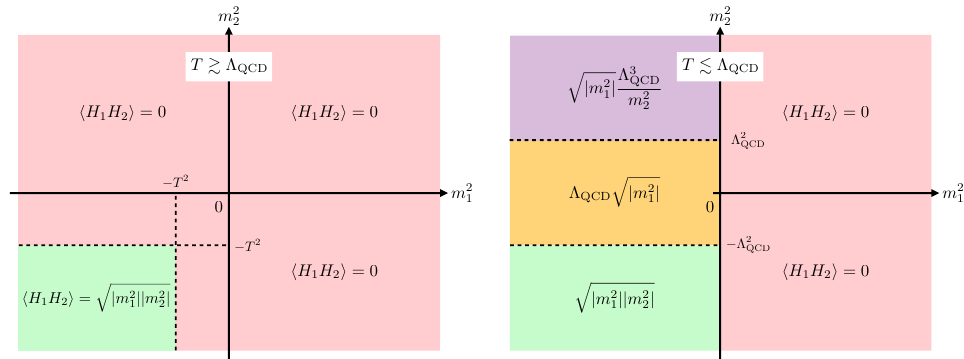
Figure 10 . Vacuum expectation value of H 1 H 2 in the model of eqs. (5.3) and (5.5) as a function of the two Higgs masses. We show the vev before (left) and after (right) the QCD phase transition. m 1 , 2 are effective masses with the dimensions of vevs that contain contributions from O (1) quartic couplings. Λ QCD is a function of the Higgs vevs and varies within the purple and yellow boxes. We have approximated thermal corrections to m 2 with T 2 to improve readability. Note that in the 1 , 2 light red regions the vev is not exactly zero, because of a small effective Bµ term induced by the φ ± vevs. However this effect is too small to affect our conclusions. It only gets rid of dangerous domain walls, as discussed in the main body of the